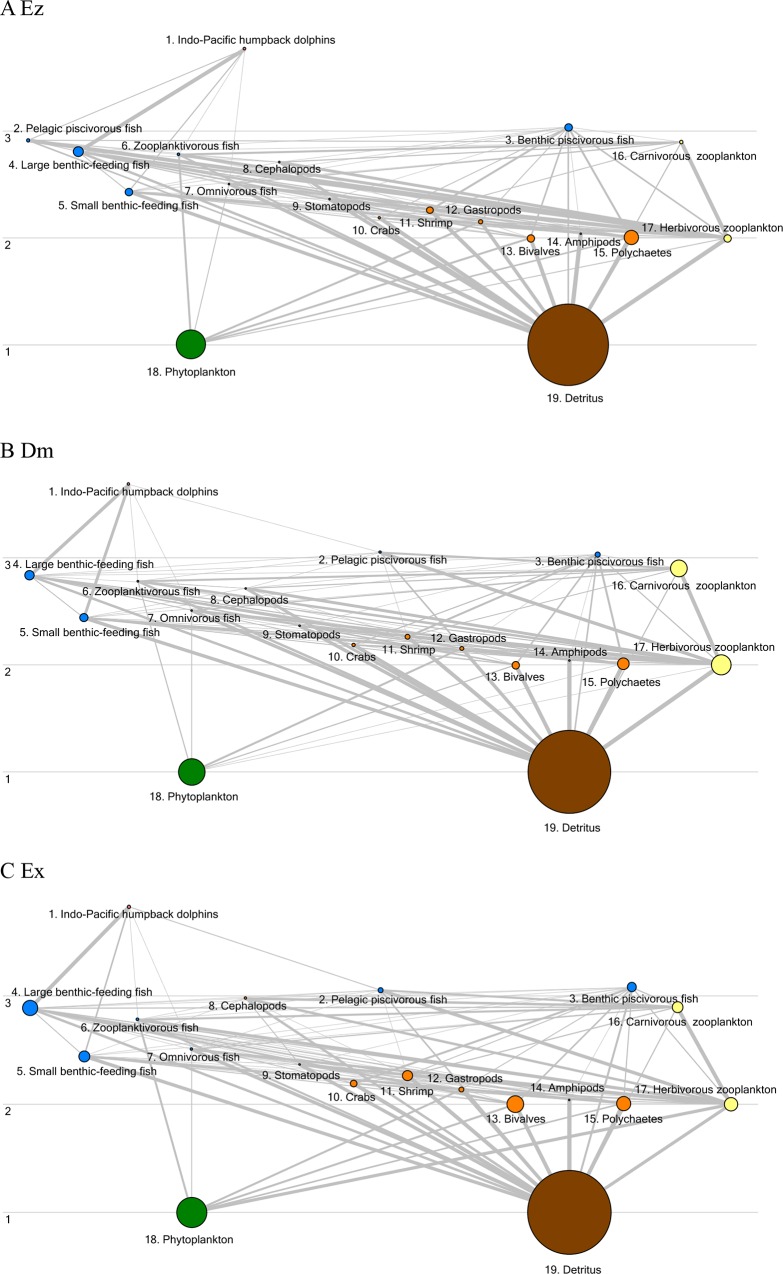
Flow diagrams for the (A) Ez, (B) Dm, and (C) Ex models. The circle sizes are proportional to the compartmental biomass, and the thicknesses of the lines are proportional to the energy flow rate.